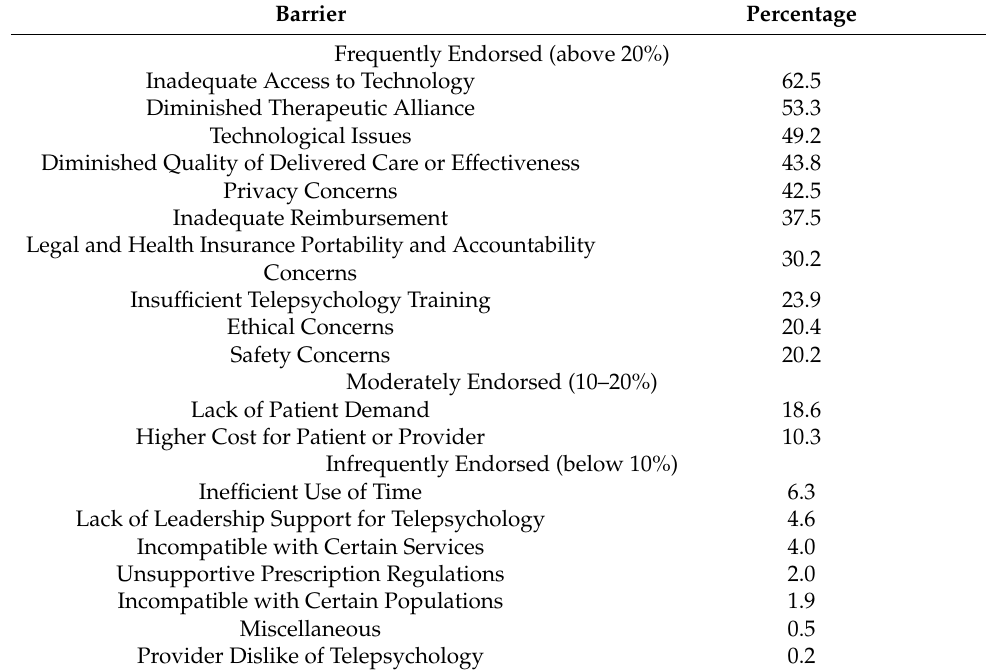
Table 3. Percentage Endorsed for Each Telepsychology Barrier and